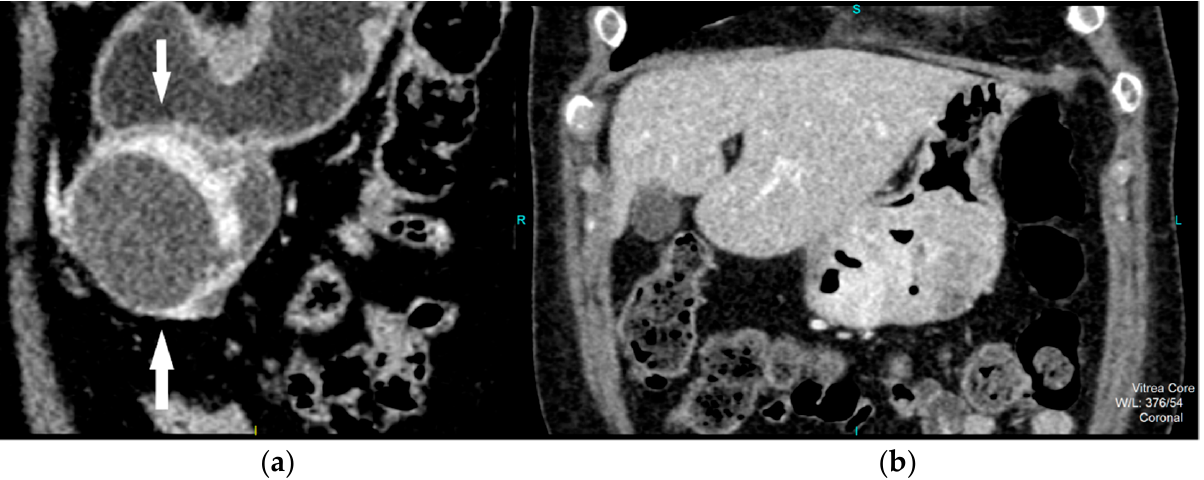
Figure 2. Contrast enhanced CT, coronal view, shows high risk GIST in a 69-year-old female patient, with a clearly demarcated submucosal lesion in the antrum of the stomach with an exophytic growth pattern and predominantly cystic structure with the strong post-contrast enhancement of solid part of tumor (arrows) ( a ). CT examination, coronal section, in a 49-year old female patient reveals intraluminal predominantly solid tumor lesion with irregular shape and margins, endophytic growth with the discontinuity of gastric mucosa and obvious post-contrast enhancement in a HR GIST ( b ).